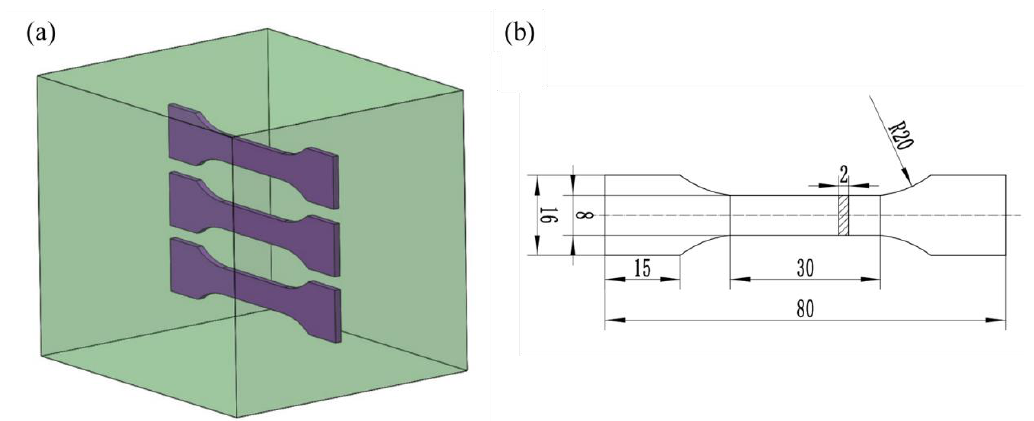
Figure 3. ( a ) Schematic diagram of the samples used in the tensile test; ( b ) dimensions of a tensile sample.